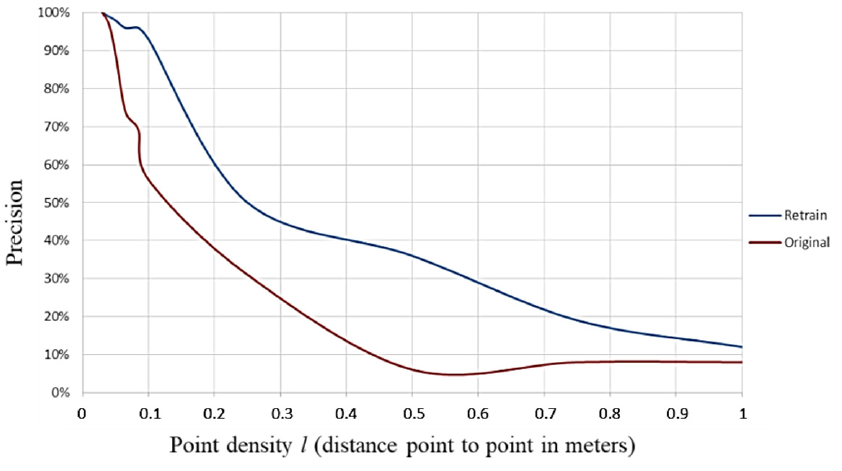
Figure 10. Comparison of precision of the re-trained and original CNN with point density varia- tion.